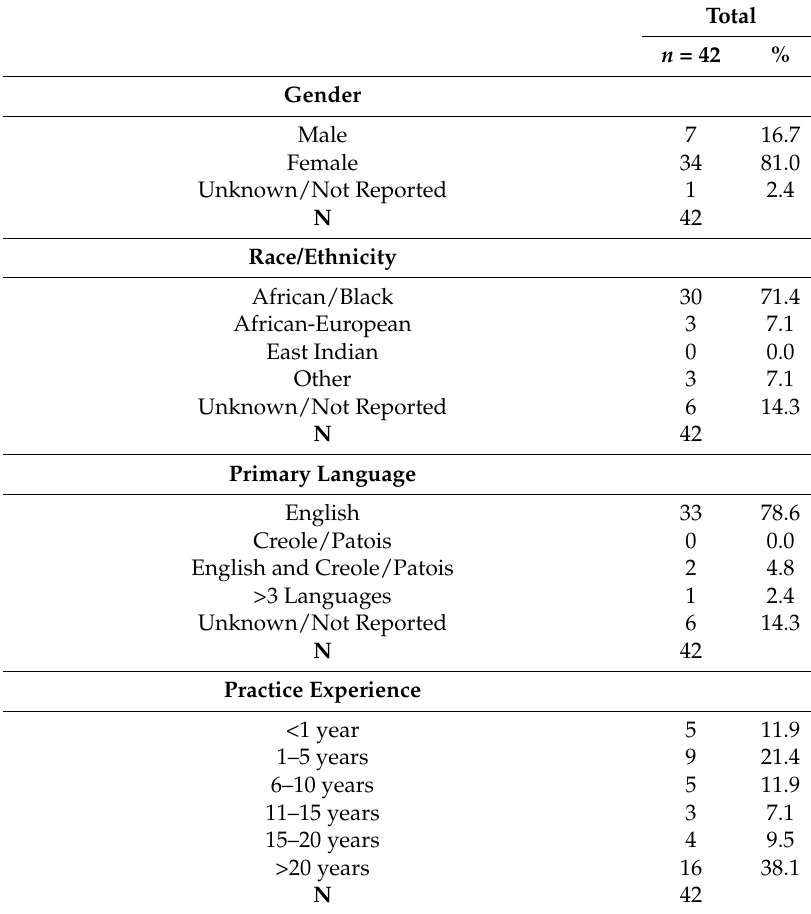
Table 2. Provider demographics and chronic disease